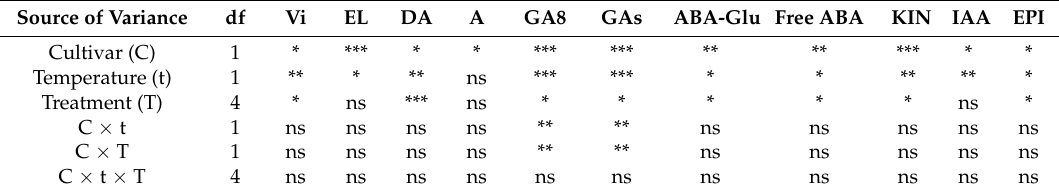
Table 1. Effects of temperature and seed treatment (two-way ANOVA) on germination vigour index (Vi), ion leakage (EL), dehydrogenase (DA) and α -amylase (A) activity, content of inactive gibberellin (GA 8 ), active gibberellins (GAs), conjugated abscisic acid (ABA-glc), free ABA, kinetin (KIN), indole-3-acetic acid (IAA) and 24-epibrassinolide (EPI) in the seeds of two L. angustifolius cultivars germinated at 7 ◦ C or 13 ◦ C in water or after pre-sowing treatments: Three-hour hydropriming or 10 − 6 M, 10 − 5 M, 10 − 4 M